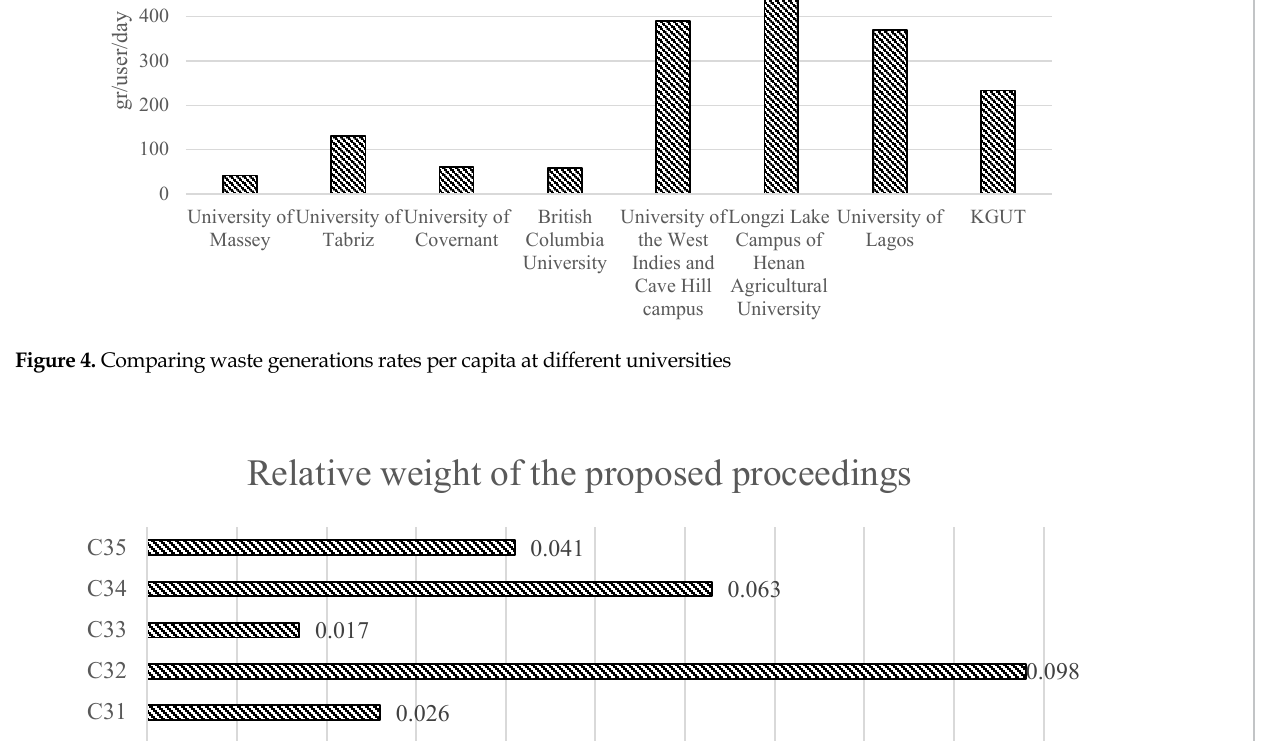
Table 2. Mean Matrix of Paired Comparisons Obtained From 15 Surveys